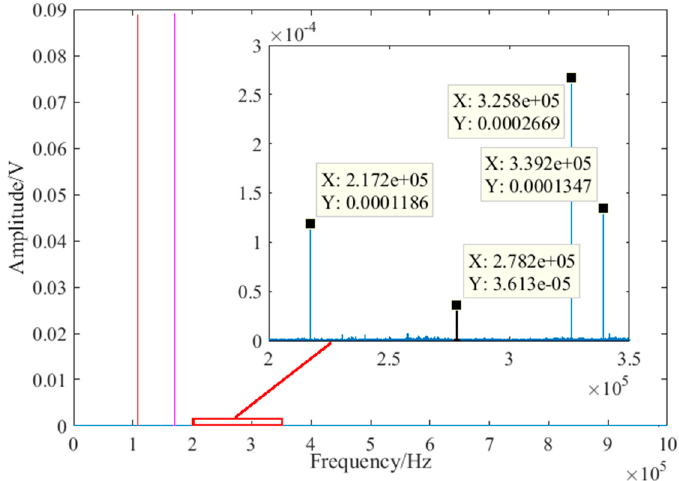
Figure 8. The received modulation signal under undamaged conditions.